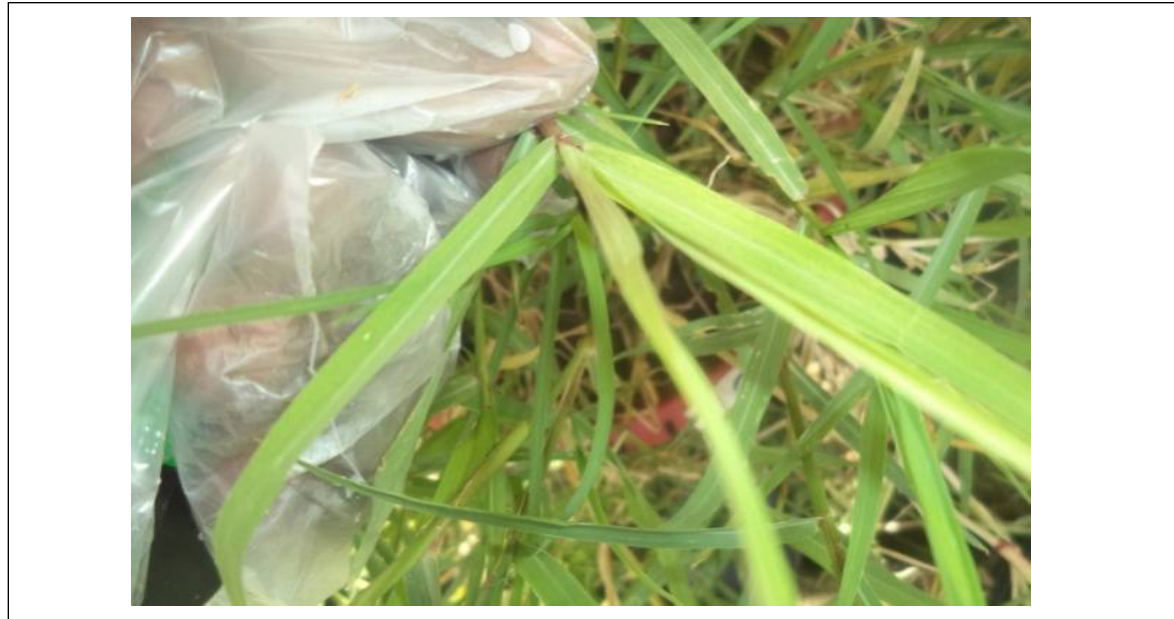
Figure 2: Chlorotic Sugarcane mosaic virus symptoms observed in Cynodon dactylon grass species following mechanical inoculation in a green house in